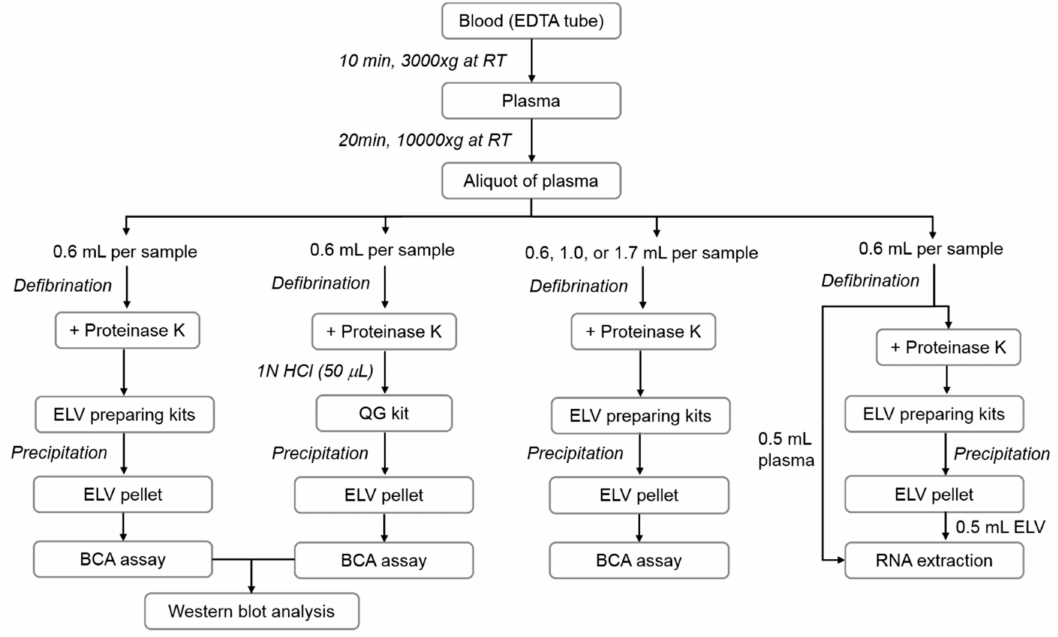
Figure 1. Schematic overview of experimental procedures with di ff erent protocols to isolate plasma extracellular vesicles (ELVs). EDTA, ethylenediaminetetraacetic acid; RT, room termperature; QG kit, miRCURY Exosome Serum / Plasma